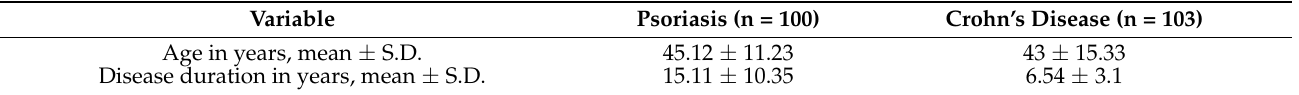
Table 2. Clinical activity index at baseline and clinical activity index after 6 months of treatment for psoriasis and 24 months for Crohn’s disease patients.